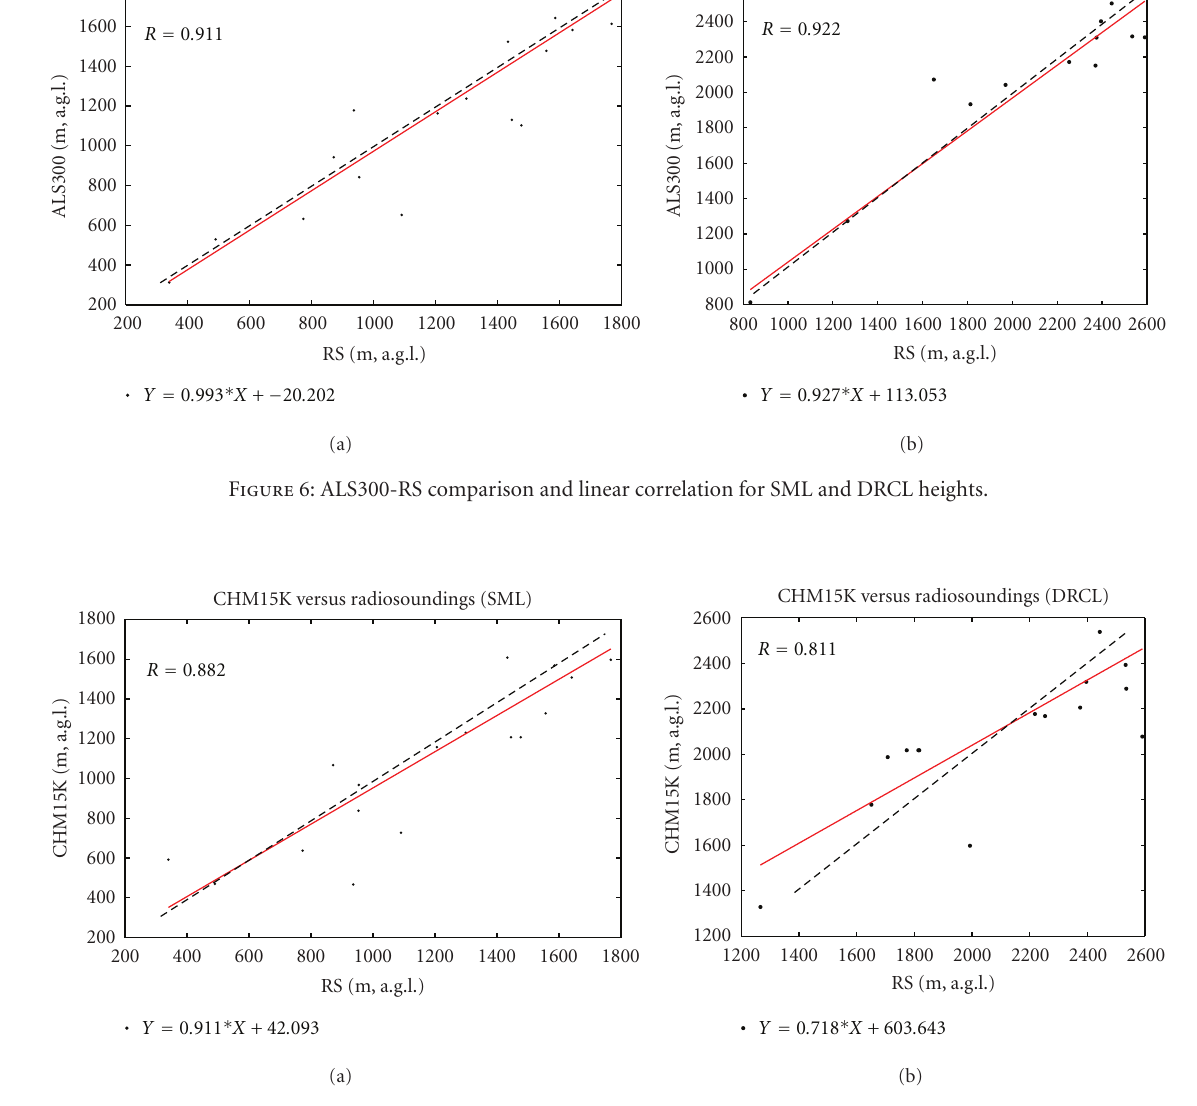
Figure 7: CHMK15K-RS comparison and linear correlation for SML and DRCL